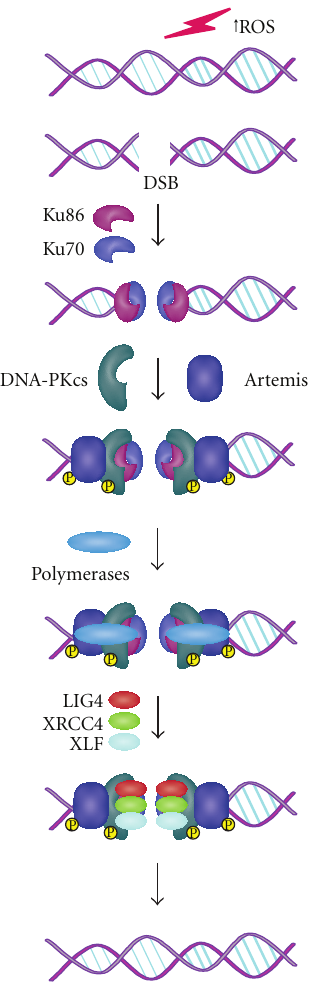
Figure 1: ROS can generate double-strand breaks with heteroge- neous incompatible DNA ends. Following DSB formation, Ku70 and Ku86 form the heterodimer Ku, which can bind directly the two broken DNA termini. Ku, likely changing conformation once it slides onto the DNA end, recruits DNA-PKcs and Artemis to form the DNA-PK complex, which brings the two DNA ends close together and protects them from excessive degradation. DNA-PK phosphorylates itself and also mediates a regulatory phosphoryla- tion of other NHEJ components, such as Artemis. Subsequently, the DNA polymerases (including the pol X polymerases, pol μ and λ ) synthetize each DNA segment necessary for the repair. Finally, the DNA-PK complex recruits the LIG4-XRCC4-XLF complex in order to perform the ligation of the DNA termini, after which the DNA- repair factors